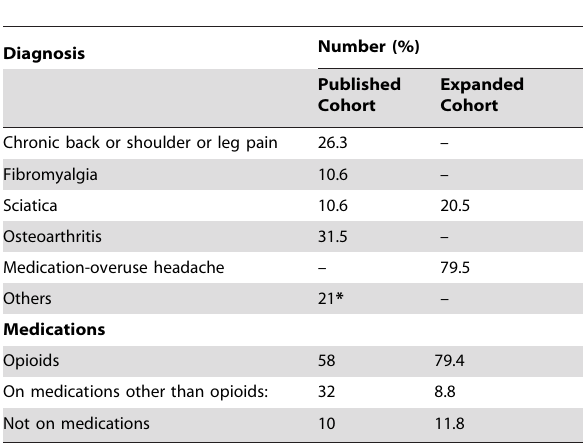
Table 9. Primary diagnoses and medications of chronic pain patients (n =53).